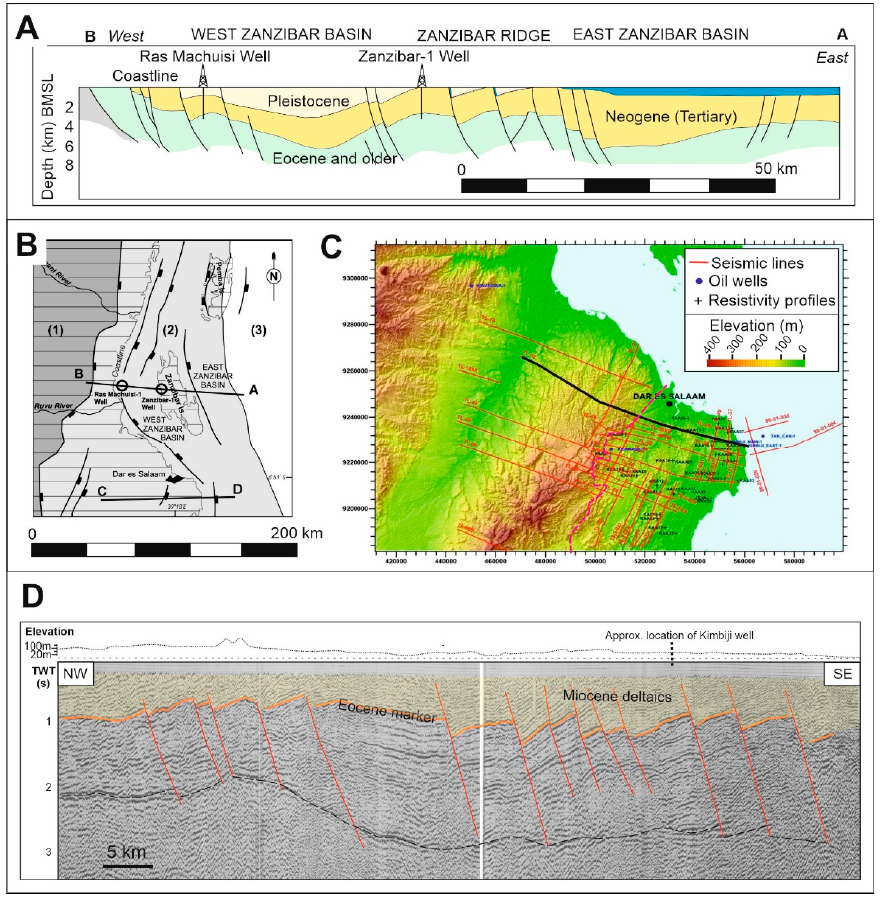
Figure 13. ( A ) Conceptual model: schematic geological cross-section (modified from: Tanzania Petroleum Development Corporation archives, 1992), approximate location in Figure 13B. The blue color indicates seawater; the water depth between the Zanzibar ridge and the western coastline is too shallow to be visible at this scale. ( B ) Location map of the Tanzania region showing the location of the schematic geological cross-section in Figure 13A. ( C ) Location map for the Kimbiji Aquifer project. The purple dashed line defines the aquifer boundaries. ( D ) Seismic section onshore Tanzania, location in Figure 13C. The Kimbiji Aquifer is hosted in deltaic sediments of (mainly) Miocene age. A calibrated high- amplitude seismic reflector representing top Eocene carbonates served as a marker horizon (orange) to define the base of the Kimbiji Aquifer system. The stratigraphic sequence is extensively faulted, due to the development of the East African Rift system and giving rise to a sedimentary basin, which thickens towards and extends beneath the Indian Ocean. (Seismic data courtesy of F. Ruden at Ruden AS) (Figures modified from: [139,141,144]).